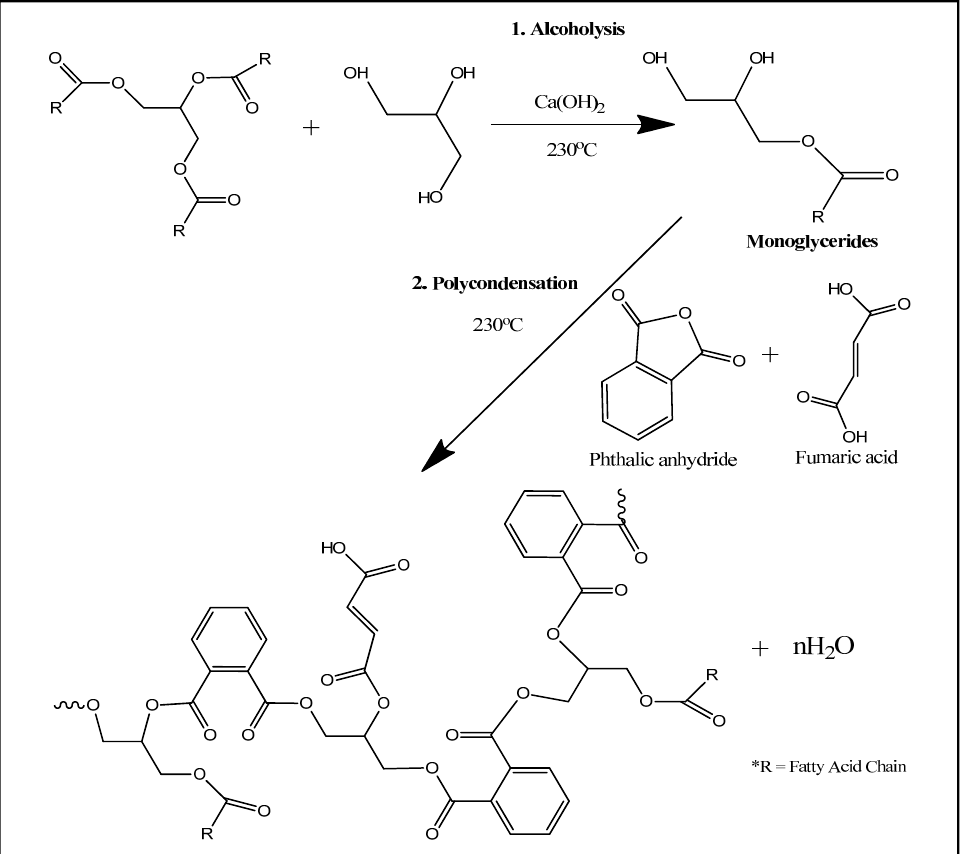
Figure 1. A plausible scheme of reactions in the synthesis of palm oil-based alkyd.